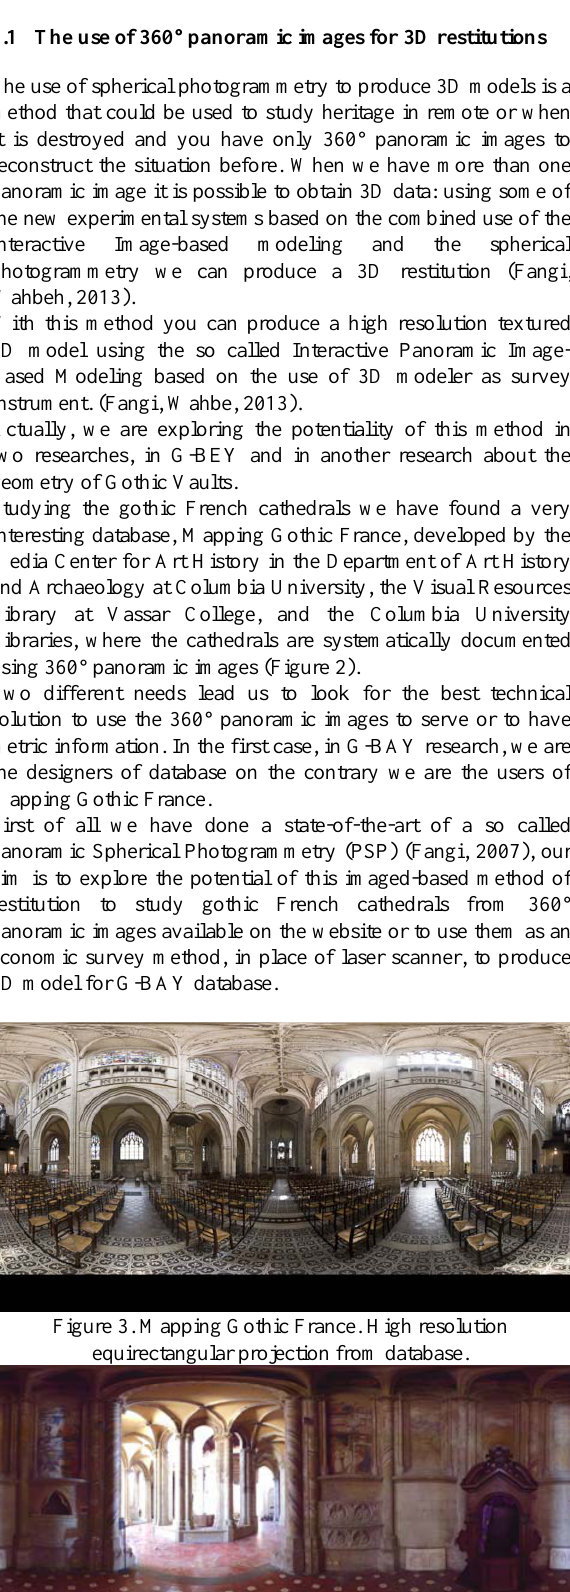
Figure 4 . Naples S. Lorenzo Maggiore. Equirectangular projections from laser